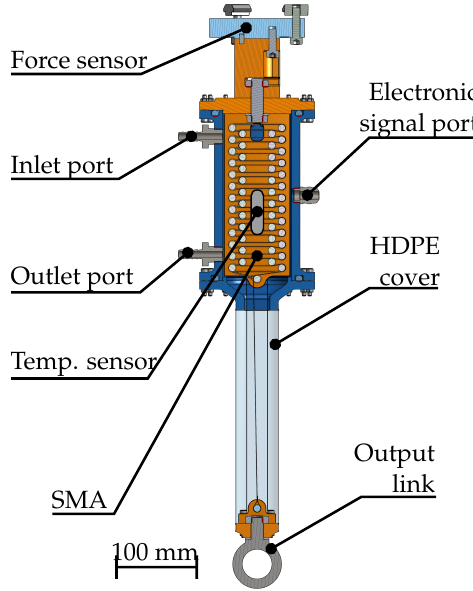
Figure 15. Construction details of the